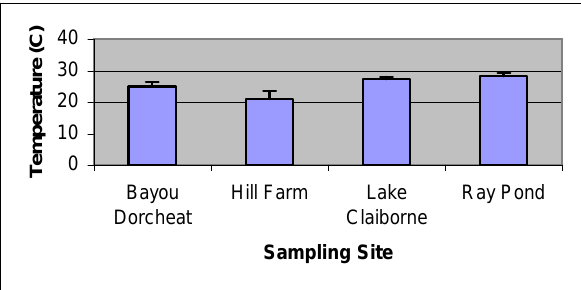
Figure 8: Mean values (n=15) of temperatures ( ° C) at each sampling